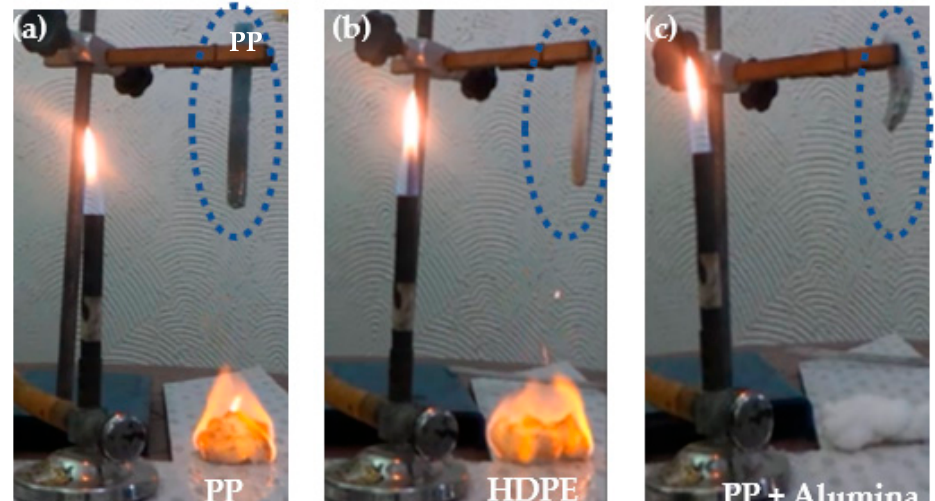
Figure 10. Cotton fiber results after the flammability test: ( a ) PP; ( b ) HDPE; ( c ) PP + 5% alumina.